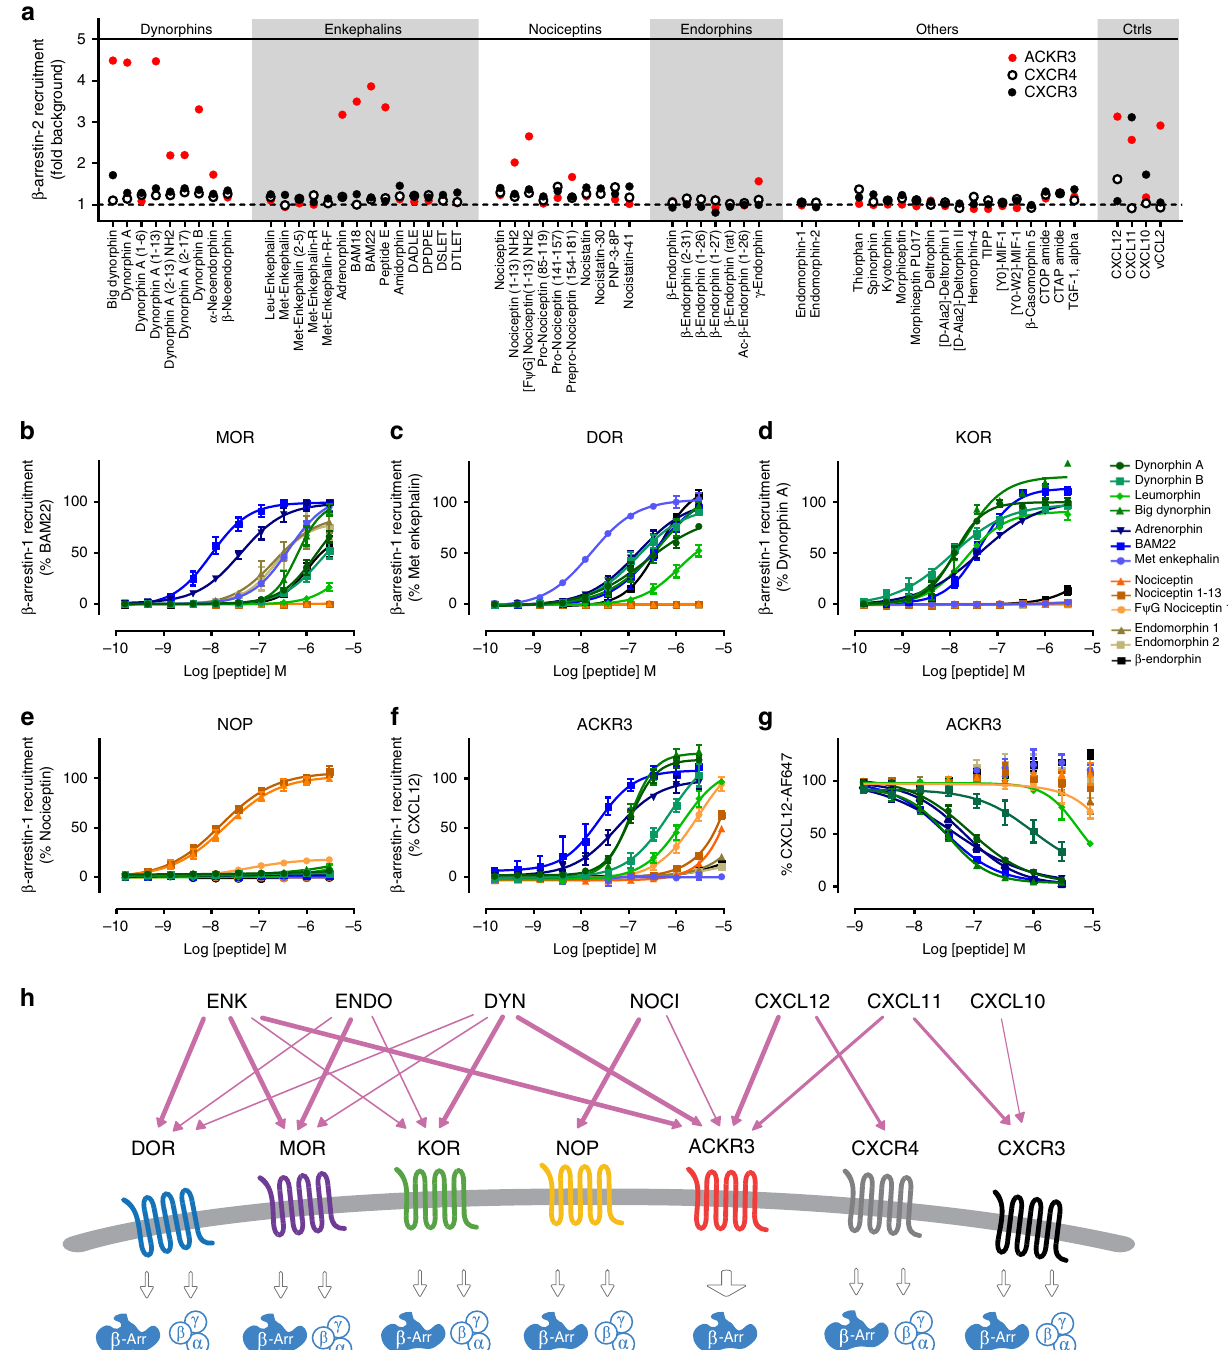
Fig. 1 Opioid-peptide library screening on ACKR3 and hit activity comparison. a The ability of 58 compounds, including natural opioid peptides from the four opioid families, variants thereof and small molecule opioid receptor modulators, to induce β -arrestin-2 recruitment to ACKR3, CXCR4 and CXCR3 in U87 cells at a concentration of 5 µ M. For full peptide names and sequences, see Supplementary Table 1. Chemokine positive controls (Ctrls) were used at a concentration of 300 nM. Results are expressed as fold change over vehicle-treated cells and presented as mean of two technical replicates for ACKR3 and CXCR4. A single measurement was performed for CXCR3. b – f Comparison of potency and ef fi cacy of ACKR3-activating and other representative opioid peptides in inducing β -arrestin-1 recruitment to the opioid receptors MOR ( b ), DOR ( c ), KOR ( d ), NOP ( e ), and ACKR3 ( f ) in U87 cells. Results are expressed as percentage of indicated agonist response. The corresponding EC 50 and Emax values are summarized in Table 1. g Binding competition of ACKR3-activating and other representative opioid peptides with Alexa Fluor 647-labeled CXCL12 (5 nM) on U87-ACKR3 cells determined by fl ow cytometry. Results from b-g are presented as mean ± S.E.M of three or four independent experiments ( n = 3 or 4). Peptides from the enkephalin, dynorphin, nociceptin and endorphin families are depicted in blue, green, orange and gray scale, respectively. h Schematic representation of the interactions of the four opioid receptors and chemokine receptors with their respective ligands. The newly identi fi ed opioid peptide pairings with ACKR3 are shown, highlighting the cross-family selectivity of ACKR3. Source data are provided as Source Data fi